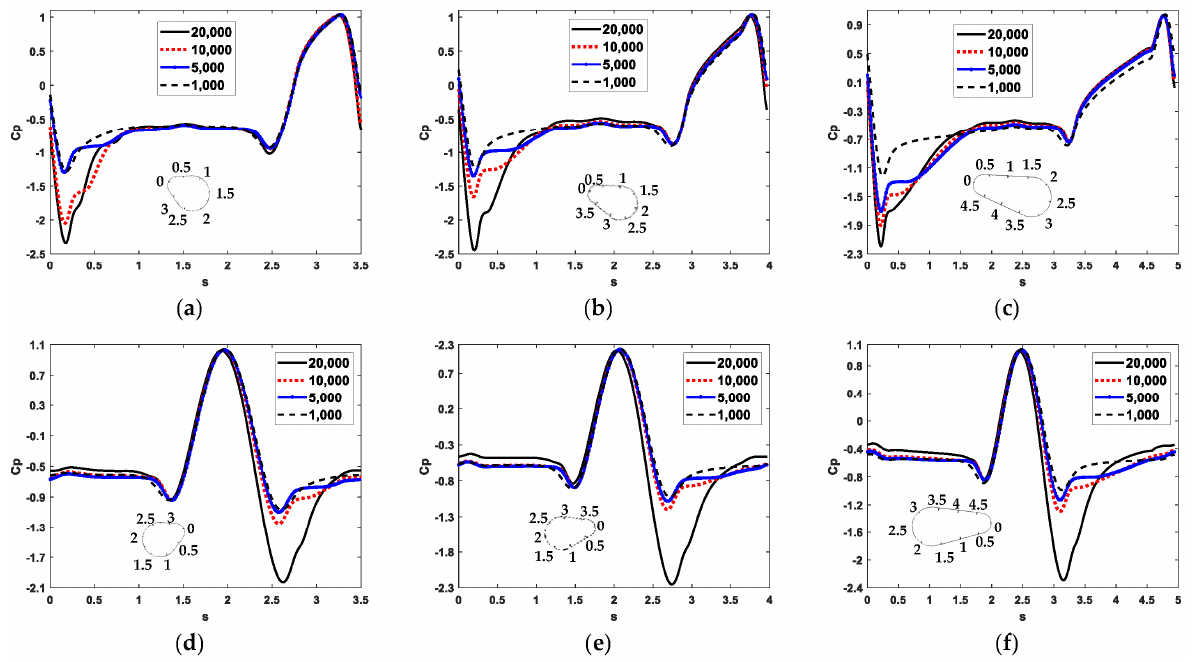
Figure 11. Distribution of mean pressure coefficient of iced conductor at different wind speed: ( a ) 0.25D-27°, ( b ) 0.5D-20°, ( c ) 1.0D-14°, ( d ) 0.25D-155°, ( e ) 0.5D-168°, and ( f ) 1.0D-176°.